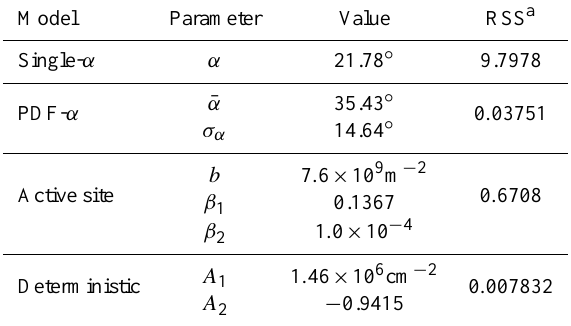
Table 2. Fit parameters obtained for illite. Best fits were obtained by minimizing the weighted residual sum of squares between the experimental data and the fit function. See text for further discus- sion on the models